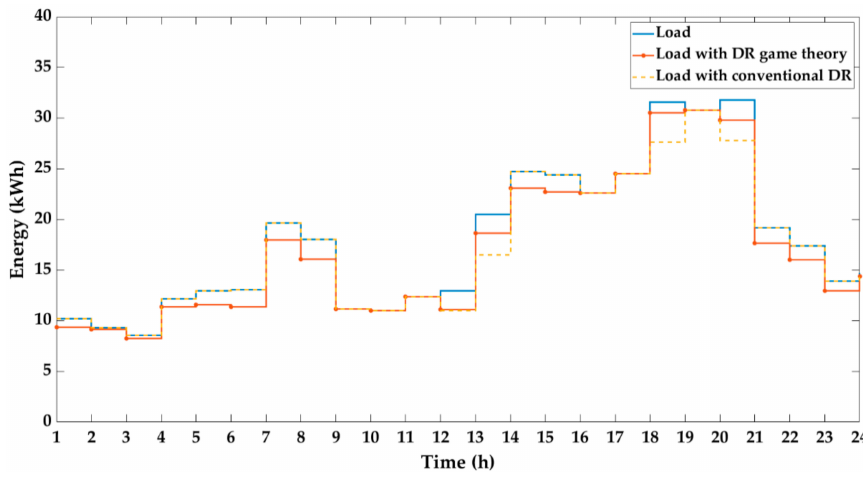
Figure 7. Load patterns of each demand response (DR) strategy.